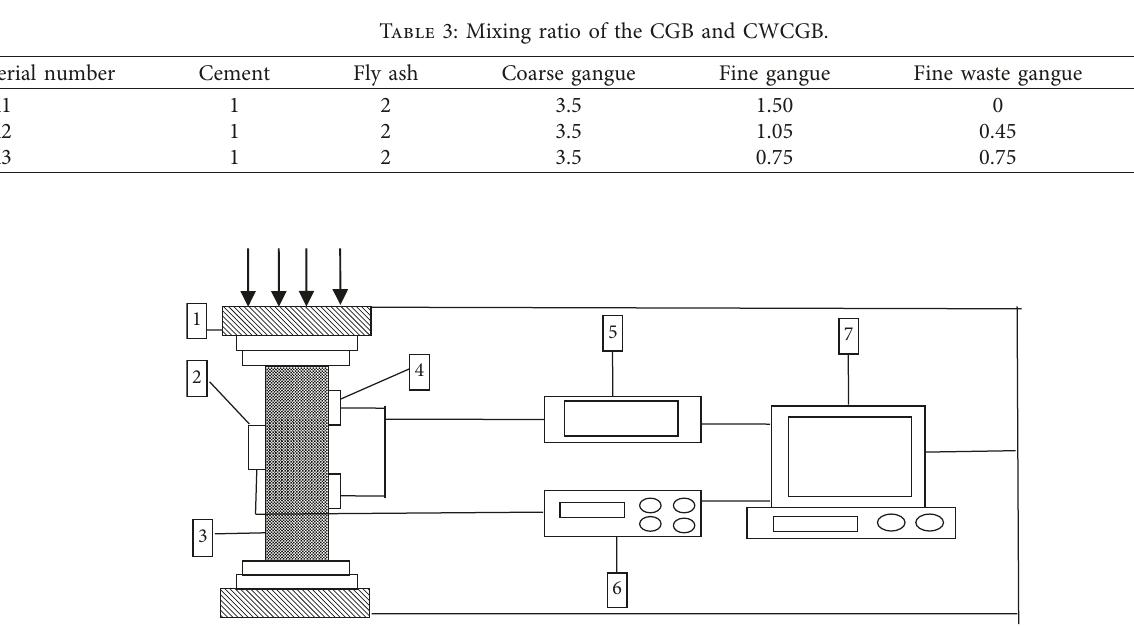
Figure 3: Stress–strain–ultrasonic–AE testing device diagram.1, insulation pad; 2, ultrasonic probe; 3, specimen 4, acoustic emission probe; 5, acoustic emission detector; 6, ultrasonoscope; 7, stress control system; ultrasonic data acquisition system; stress-strain data acquisition system; AE data acquisition system.